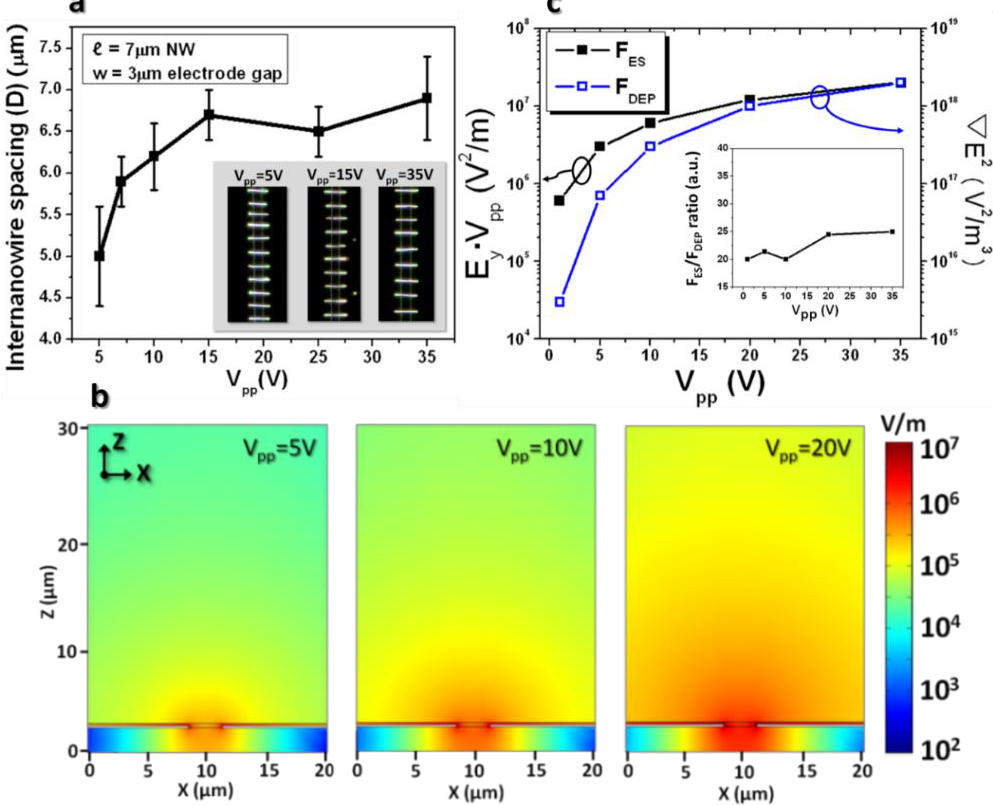
Figure 4. Inter-nanowire spacing as a function of the applied bias. ( a ) Plot of average nanowire spacing as a function of the voltage of applied bias, V pp . Apparently, the inter-nanowire spacing increases gradually as the voltage of applied bias ramps up from 5 V to 35 V. Dark field optical microscope images of the nanowire array are obtained from V pp = 5, 15, and 35 V. Scale bar = 5 μm. ( b ) Normalized electric field simulation at different voltages of applied bias (V pp = 5, 10, and 20 V) exhibiting the electric field’s spread toward the liquid medium. The nanowires will be polarized and dielectrophoretically attracted toward the electrode gap if they are within the decay length of the critical electric field. ( c ) Plot of the electrostatic repulsive E y ·V pp and dielectrophoretic ∇E 2 forces as functions of the applied bias strength. The inset emphasizes that ratios of the electrostatic to dielectrophoretic forces increase relatively gradually as the applied bias increases.